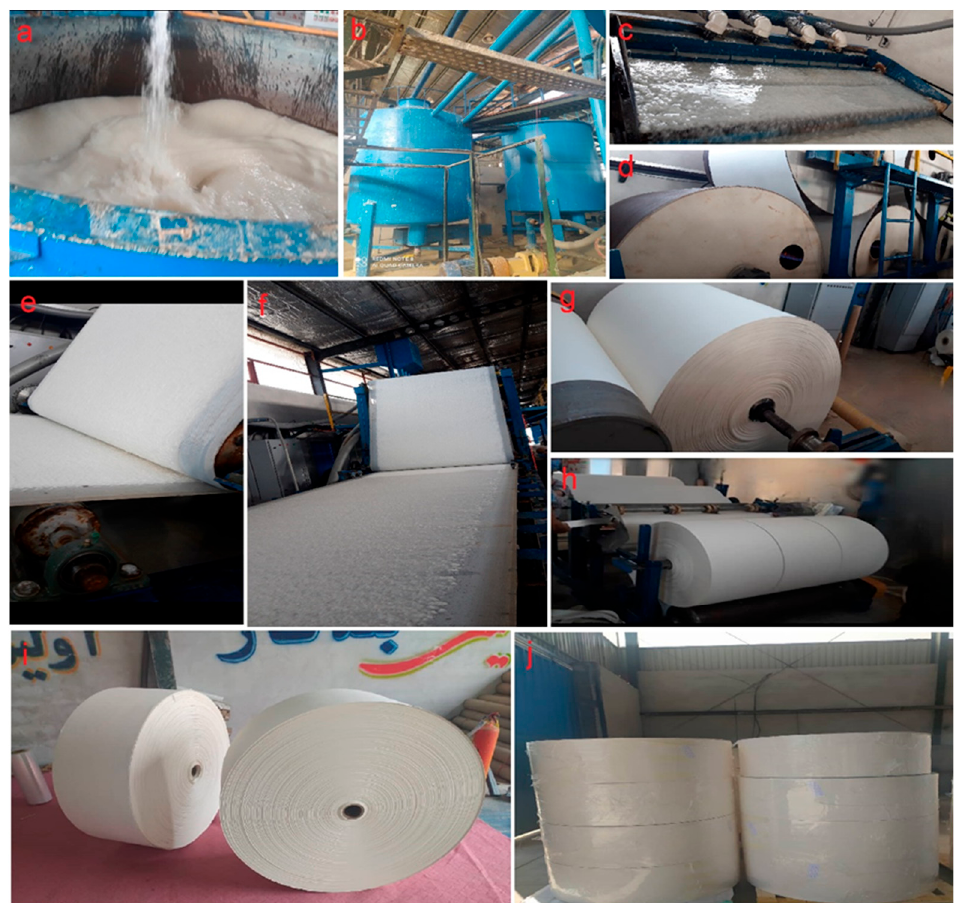
Figure 10. The processing of fluff pulp manufacturing. Pulper ( a ), storage towers ( b ), headbox ( c ), dryers ( d ), top and bottom wires ( e , f ), mother roll in the paper machine ( g ), three rolls in rewind machine ( h ) and packed rolls ( i , j ).